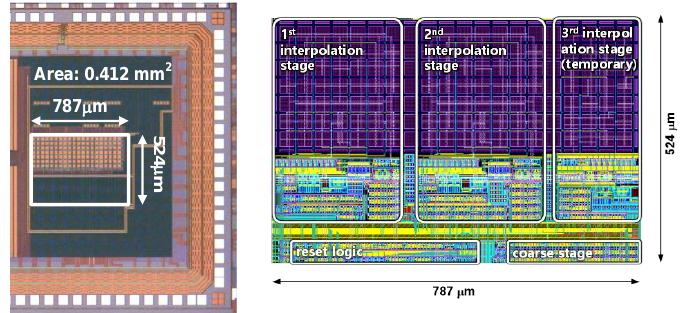
Figure 9. Chip photograph and layout.